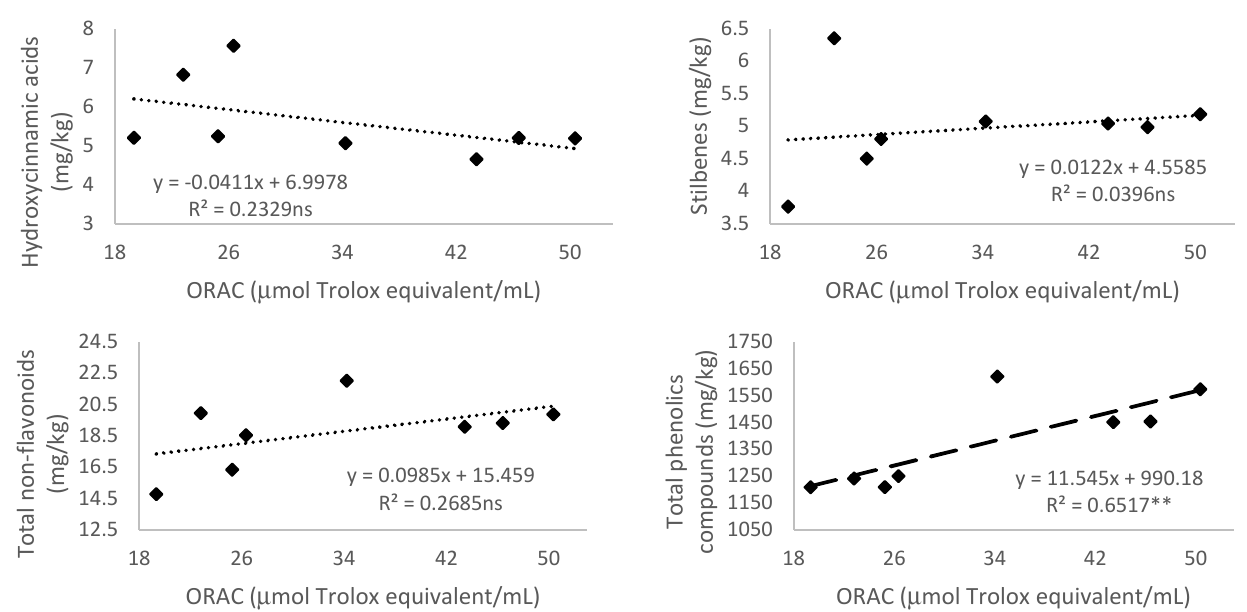
Figure 5. Relationship of the 2,2 ′ -Azobis(2-amidinopropane) dihydrochloride (AAPH)—Oxygen radical absorbance capacity (ORAC) ( µ mol Trolox/mL) and total anthocyanins, flavonols, flavanols, hydroxybenzoic and hydroxycinnamic acids, stilbenes, non-flavonoids, and content of total phenolic compounds (mg/kg) of Monastrell grapes. Values of the coefficient of determination (R 2 ) are presented. Lines of linear regression are shown: (- - -) when relationships are significant ( p < 0.05, *; p < 0.01, ** or ( · · · ) when there are no significant differences ( p > 0.05, ns).